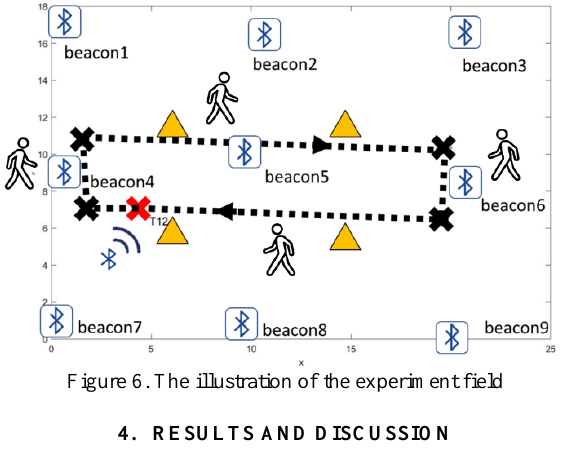
Figure 6. The illustration of the experiment field